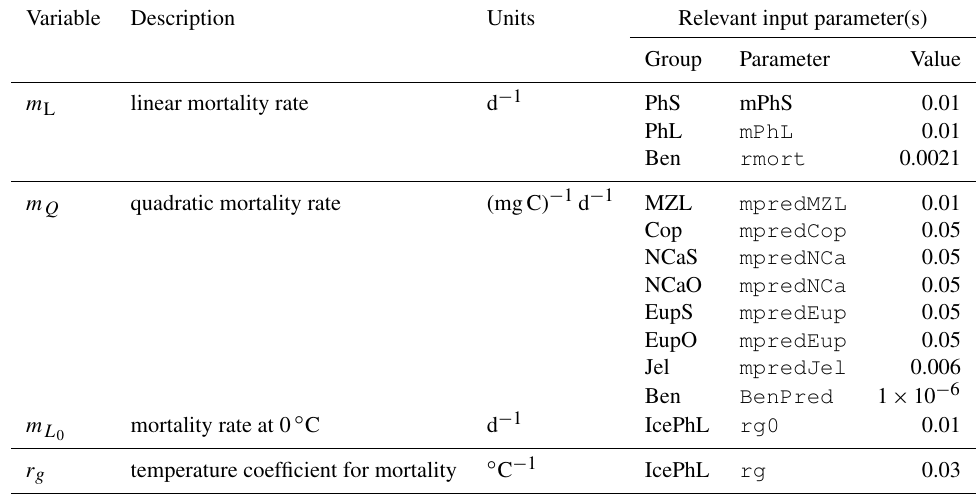
Table A10. Notation and description for input parameters related to non-predatory mortality. (See Table A6 for Q 10 parameters.)